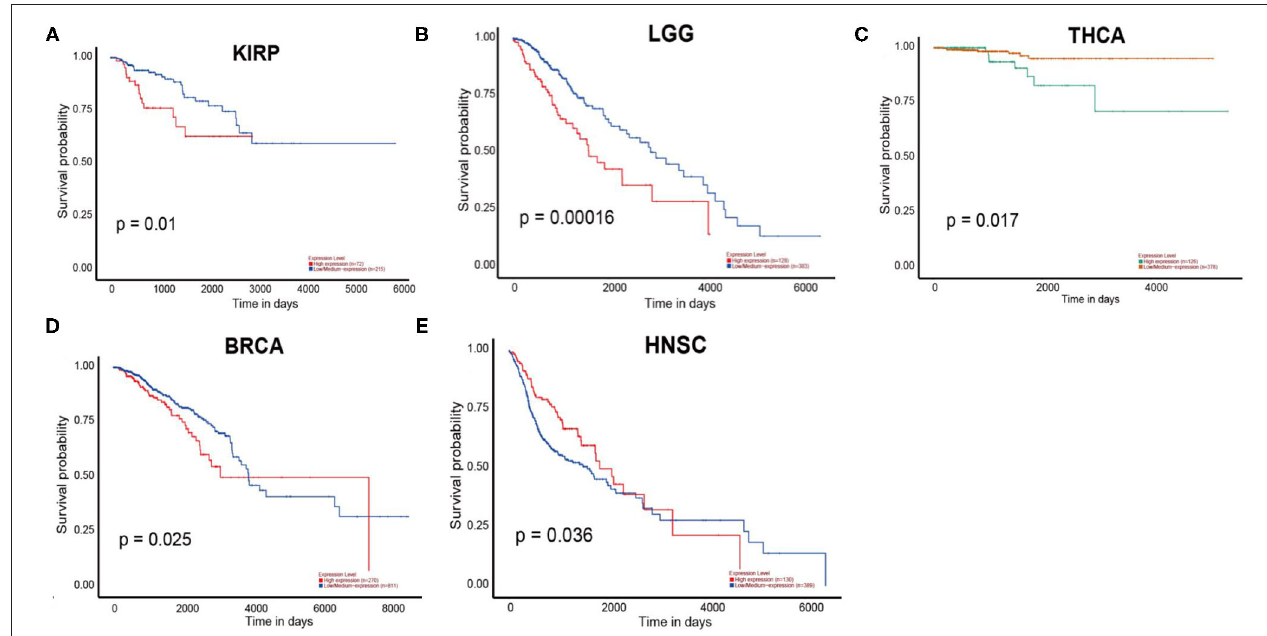
FIGURE 5 | Overall survival curves comparing the high and low expressions of PERK in five different types of cancer in the UALCAN database.